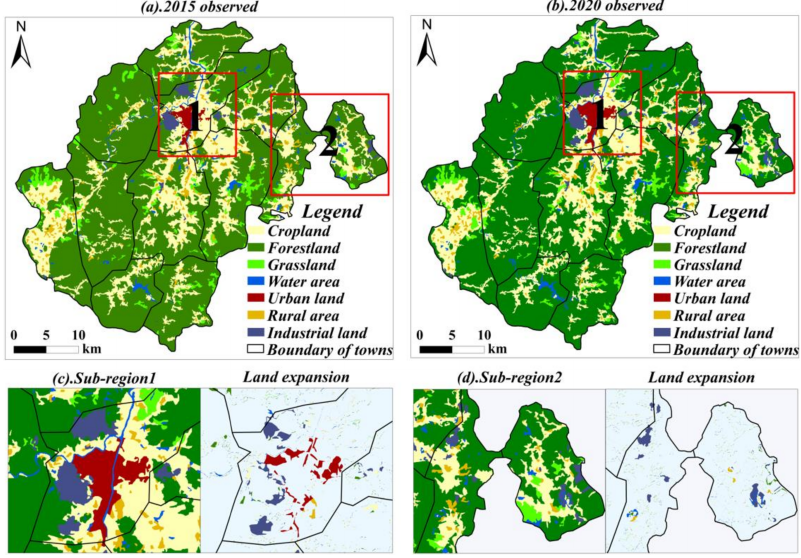
Figure 7. The LULC change map of